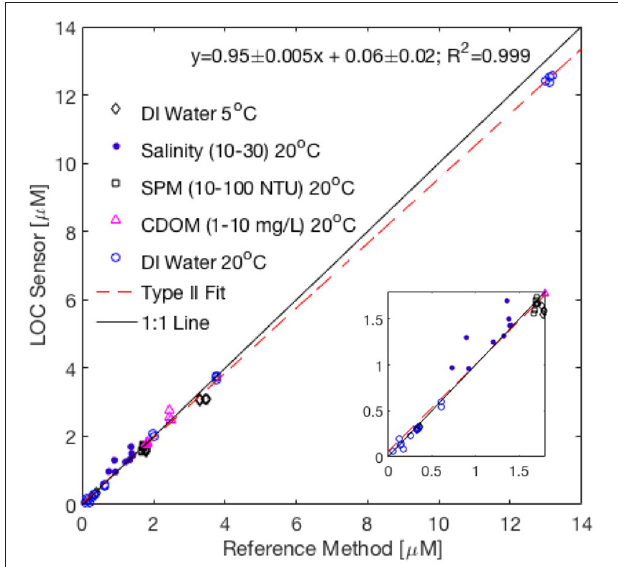
FIGURE 7 | Comparison of phosphate concentrations determined using Sensor 2 and values obtained using USEPA Reference method No 365.5 at the 17 exposure conditions tested as part of the Nutrient Sensor Challenge ( n = 62). Also included are reference and sensor measurements performed at the beginning of each day of testing, when the test tank was filled with deionized water (as low as 0.06 µ M PO 3 − 4 ). Data from the highest phosphate concentration tested (60 µ M) are not shown nor included in the fit (see text for details). The dashed shows the Type II Linear Regression between sensor and reference method. The inset graph plots the same data at a reduced scale. DI, Deionized water; SPM, Suspended Particulate Matter; NTU, Nephelometric Turbidity Units; CDOM, Colored Dissolved Organic Matter.